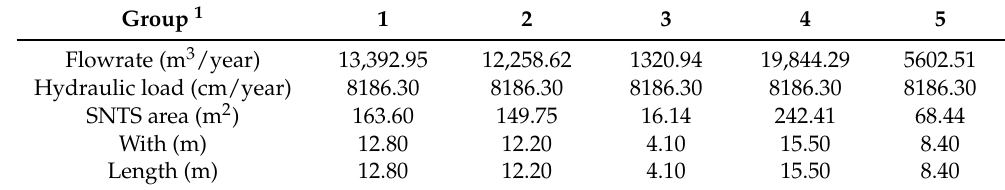
Table 5. Characteristics of the soil natural treatment system to treat greywater on Monterrey Campus. Group